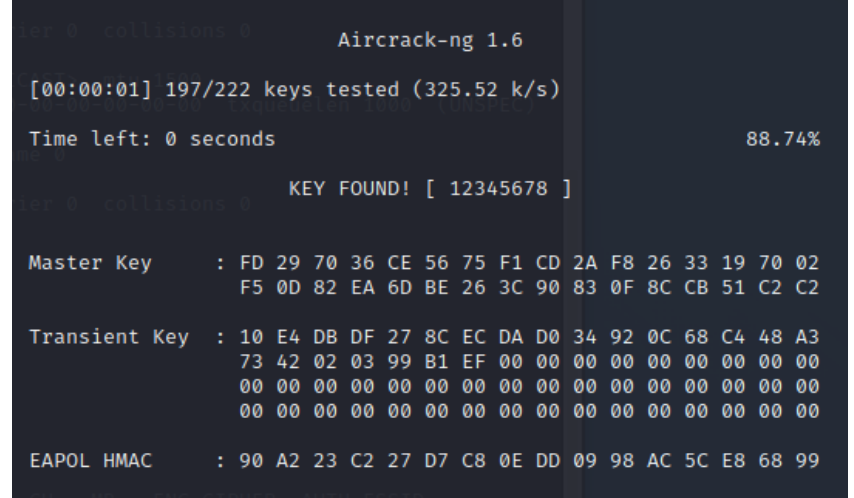
Figure 4. Aircrack-ng cracking a WPA2